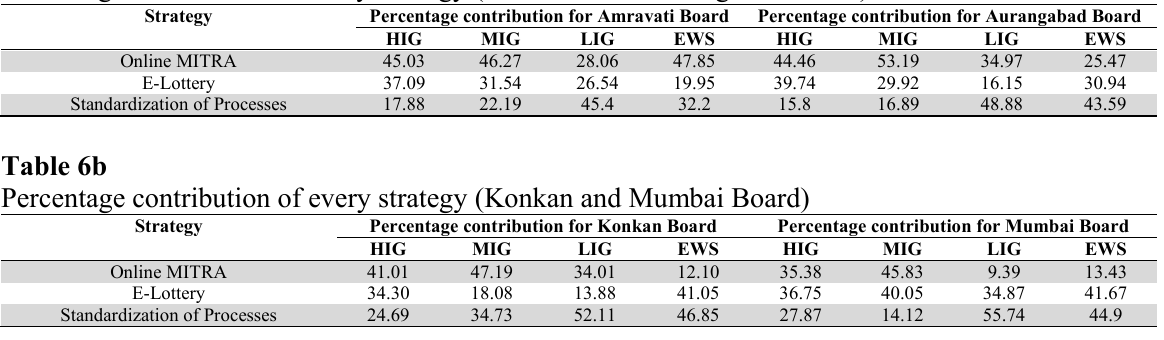
Separation value for Nagpur Board HIG